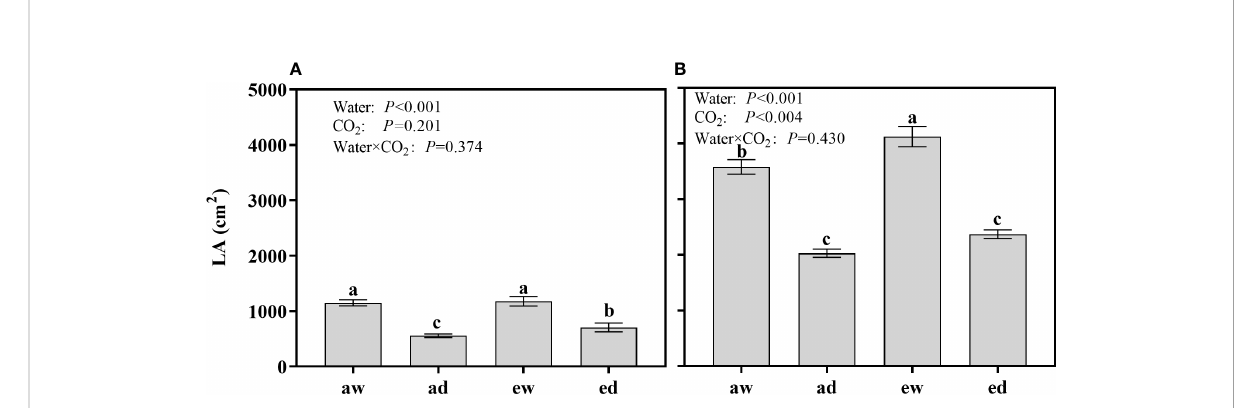
FIGURE 5 Changes of leaf area (LA) of (A) wheat and (B) maize plants grown under ambient (400 ppm, a[CO 2 ]) and elevated (800 ppm, e[CO 2 ]) atmospheric CO 2 concentrations during progressive soil drying. Error bars indicate standard error of the means (SE) (n = 4). The different small letters among treatments in the fi gure means differences signi fi cant at the 0.01